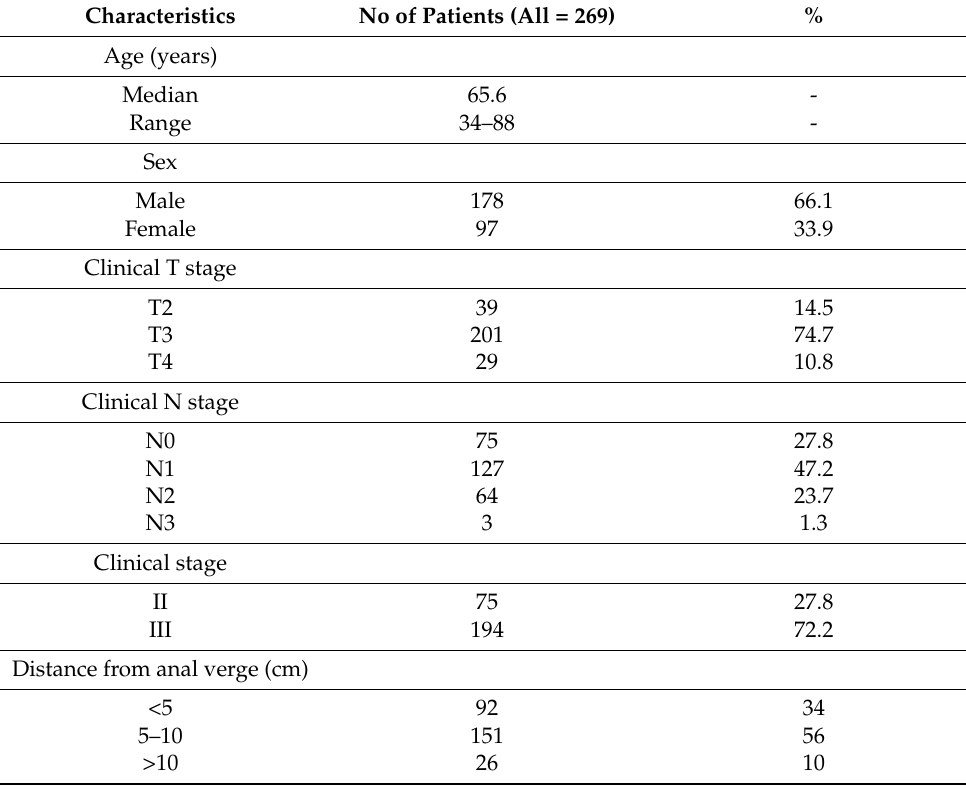
Table 1. Patient and disease characteristics.